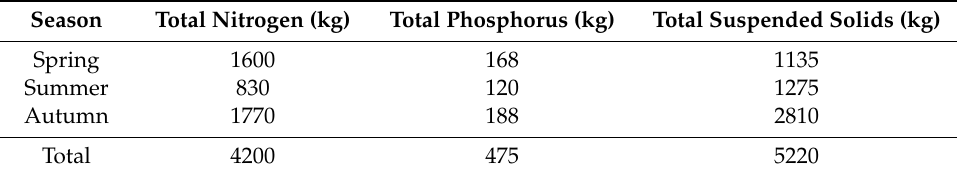
Table 2. The amount of nutrient entering the K á kafok oxbow lake.